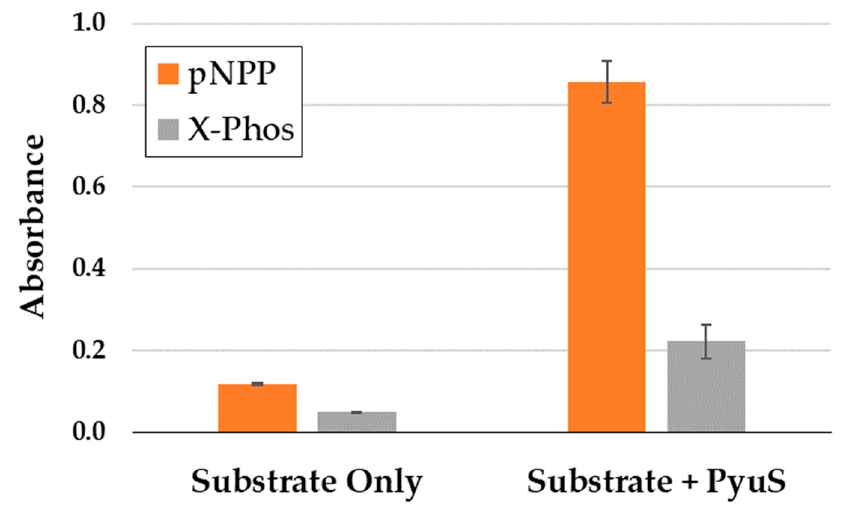
Figure 7. Activity of PyuS on phosphatase substrates pNPP and X-Phos. Products of pNPP and X-Phos were measured at 405 nm and 650 nm, respectively. Assays were performed with biological replicates.